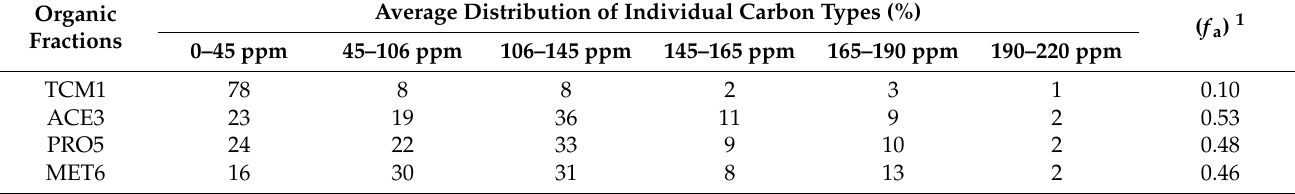
Table 4. Average distribution of individual carbon types and calculated aromaticity index ( f a ) for the studied organic fractions from the liquid-state 13 C NMR